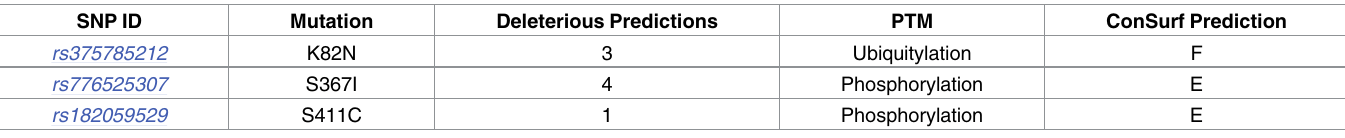
Table 5. Low risk nsSNPs identified considering PTMs and ConSurf predictions.